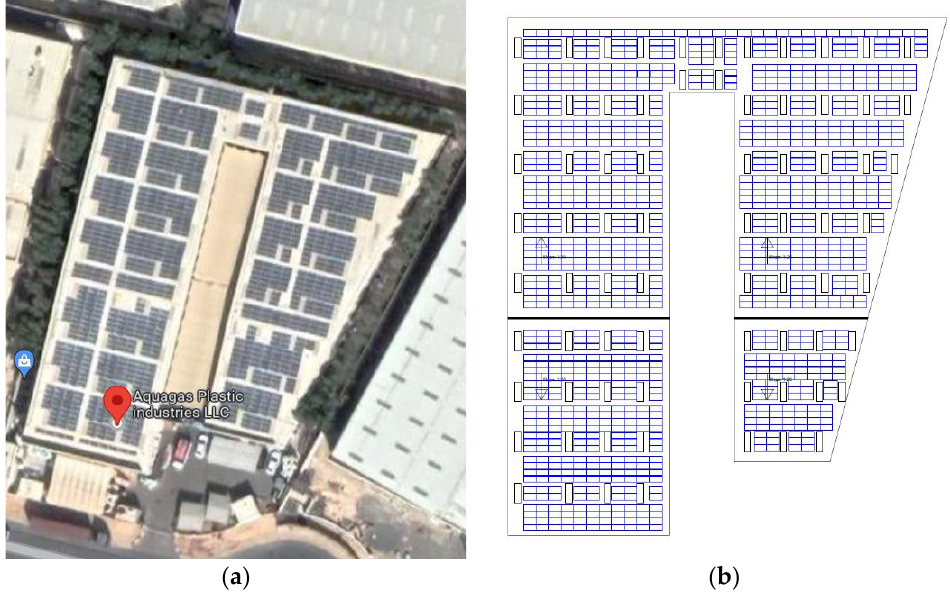
Figure 4. PV project site. ( a ) PV site top-view, and ( b ) distribution of the PV panels.